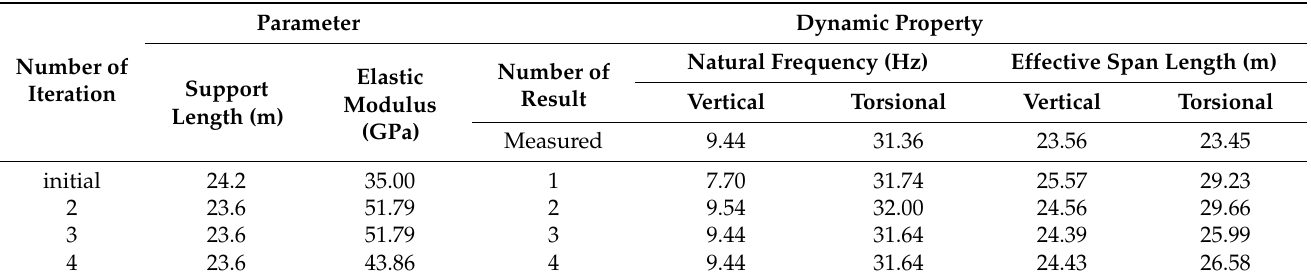
Table 7. Numerical model updating process of the Hwalchun